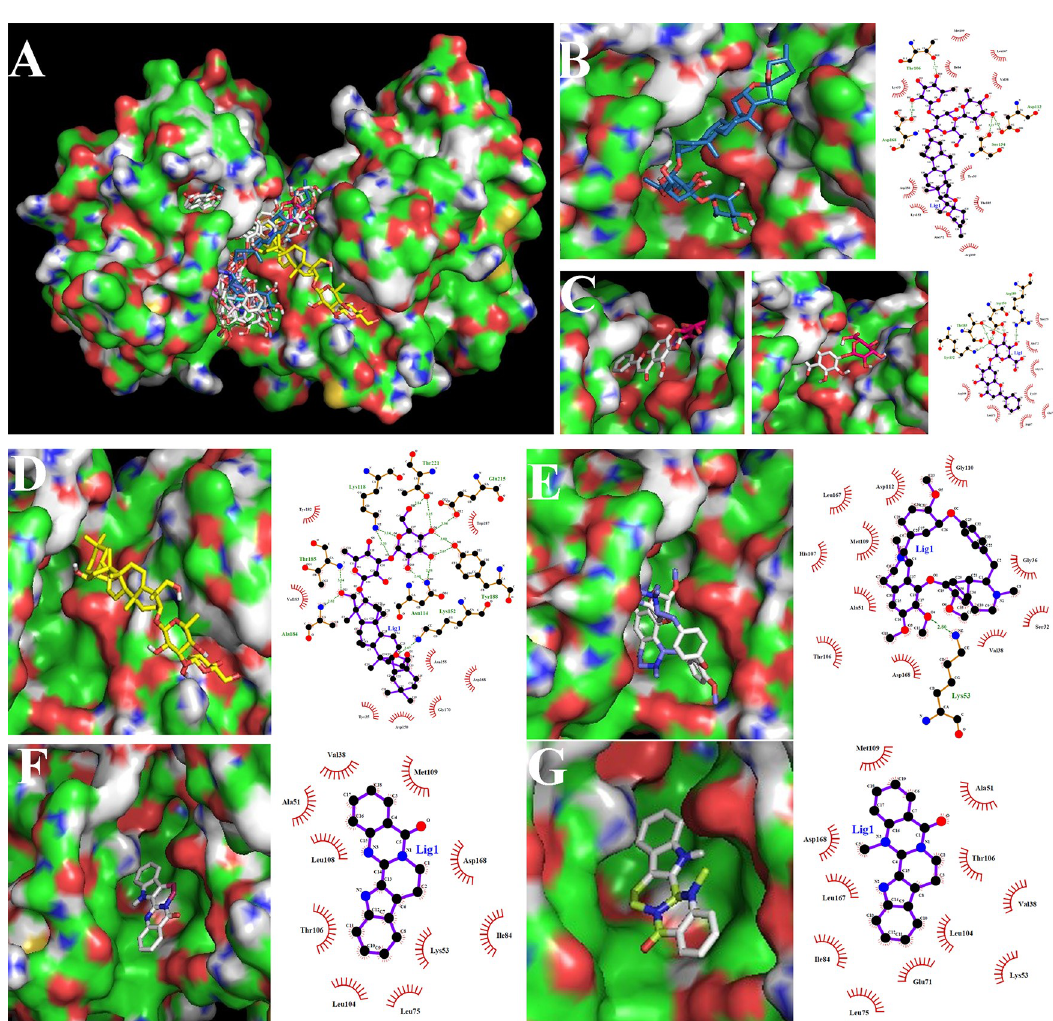
Fig 5. Docking modes between potential liver damage components and p38. Note: (A.) 32 potential liver injury components have entered the p38 α protein active pocket. (B.) The small molecule of diosgenin penetrated into the active pocket, and mainly forms four hydrogen bonds with the Thr106, Asp168, Asp112 and Ser154 residues on the protein, atotal of 15 residues were bound by hydrophobic interaction on the p38 α . (C.) The baicalin small molecule completely penetrated into the active pocket, forming 11 hydrogen bonds with the Arg189, Thr185, Asp150, Lys152, Tyr35 residues on the protein, and the sugar moiety contributed 9 hydrogens. The aglycone part contributed 2 hydrogen bonds, and more hydrophobic interaction with the protein. The hydrophobic interaction residues of the baicalin molecule were 13. (D.) The saikosaponin D molecule completely entered the active pocket, mainly with Glu215 and Thr221 on the protein, Tyr188, Asn114, Lys118, Ala184, Thr185, Lys152 residues form 13 hydrogen bonds, a total of 16 hydrophobic residues. (E.) Tetrandrine small molecules deeped into the active pocket, forming a hydrogen bond with Lys53, and 13 residues formed a hydrophobic effect. (F.) Rutaecarpine completely entered the active pocket and formed a hydrophobic interaction with 10 residues. (G.)Evodiamine completely entered the active pocket, and 11 residues formed a hydrophobic effect. increased obviously in potential liver injury components groups, suggesting that these compo- nents could exert hepatotoxicity in L-02 cells. In regard to baicalin, the baicalin group 1000 μ mol/L were associated with higher levels of ALT, AST, LDH and ALP than the blank group and the difference between both groups was not statistically significant, while the dose of 2000 μ mol/L could significantly increase the levels of ALT, AST, LDH and ALP than the blank group. Thereby baicalin could inhibit the proliferation of L-02 cells instead of inducing the cell damage. The specific composition information was shown in Table 5.